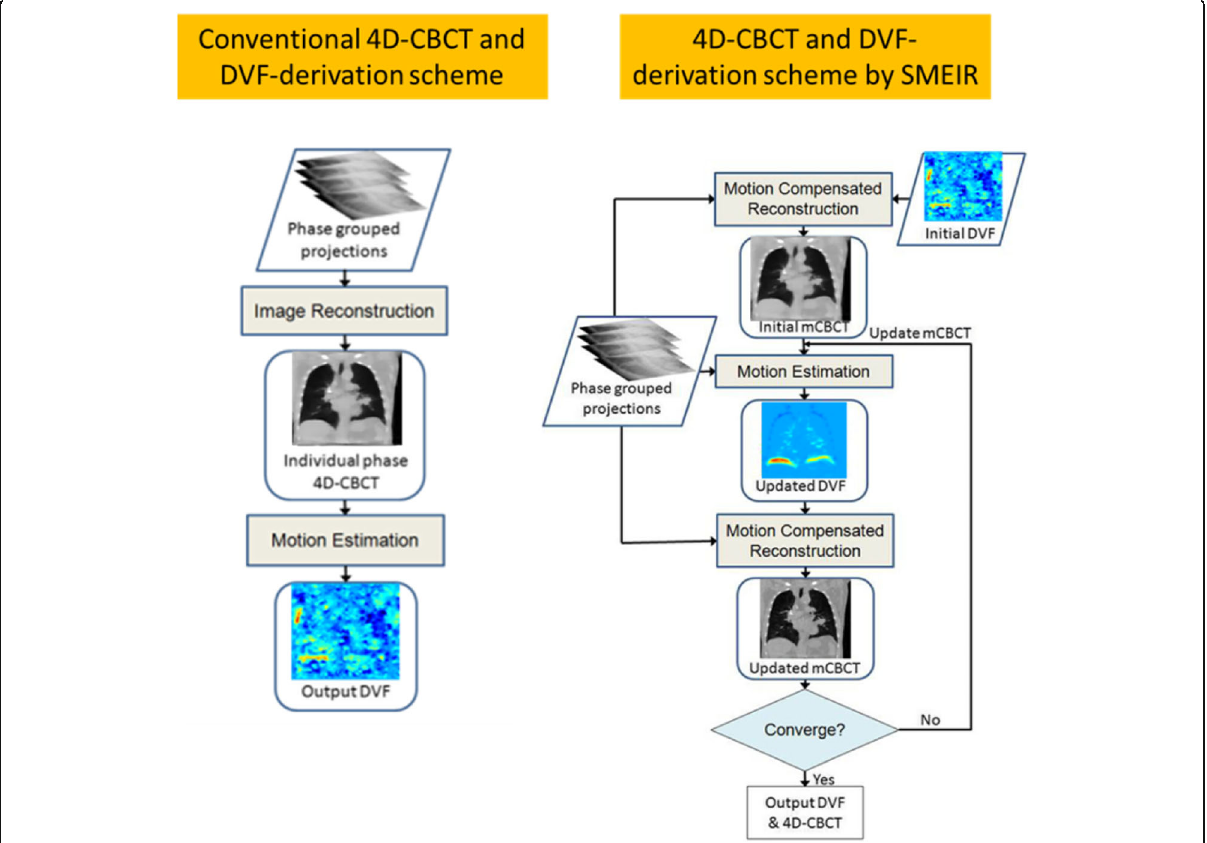
Fig. 1 Flow-chart comparison between (a) the conventional 4D-CBCT reconstruction and DVF-derivation scheme for image-guided radiation therapy/adaptive radiation therapy applications, and (b) the proposed SMEIR scheme. Compared with the conventional scheme, the SMEIR scheme updates the 4D-CBCT images and the DVFs simultaneously and iteratively in an interleaved fashion. By SMEIR, the mCBCT is updated towards improved quality to drive more accurate DVF solution, and the more accurate DVFs subsequently improve the accuracy of the motion- compensated reconstruction for mCBCT. 4D-CBCT: 4-Dimensional cone-beam computed tomography; SMEIR: Simultaneous motion estimation and image reconstruction; DVF: Deformation-vector-field; mCBCT: Motion-compensated